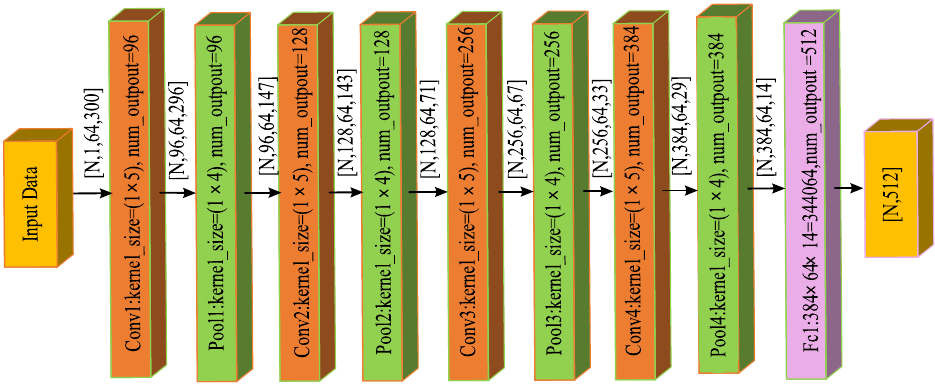
Figure 5. The whole CNN network structure and data processing course in Caffe.